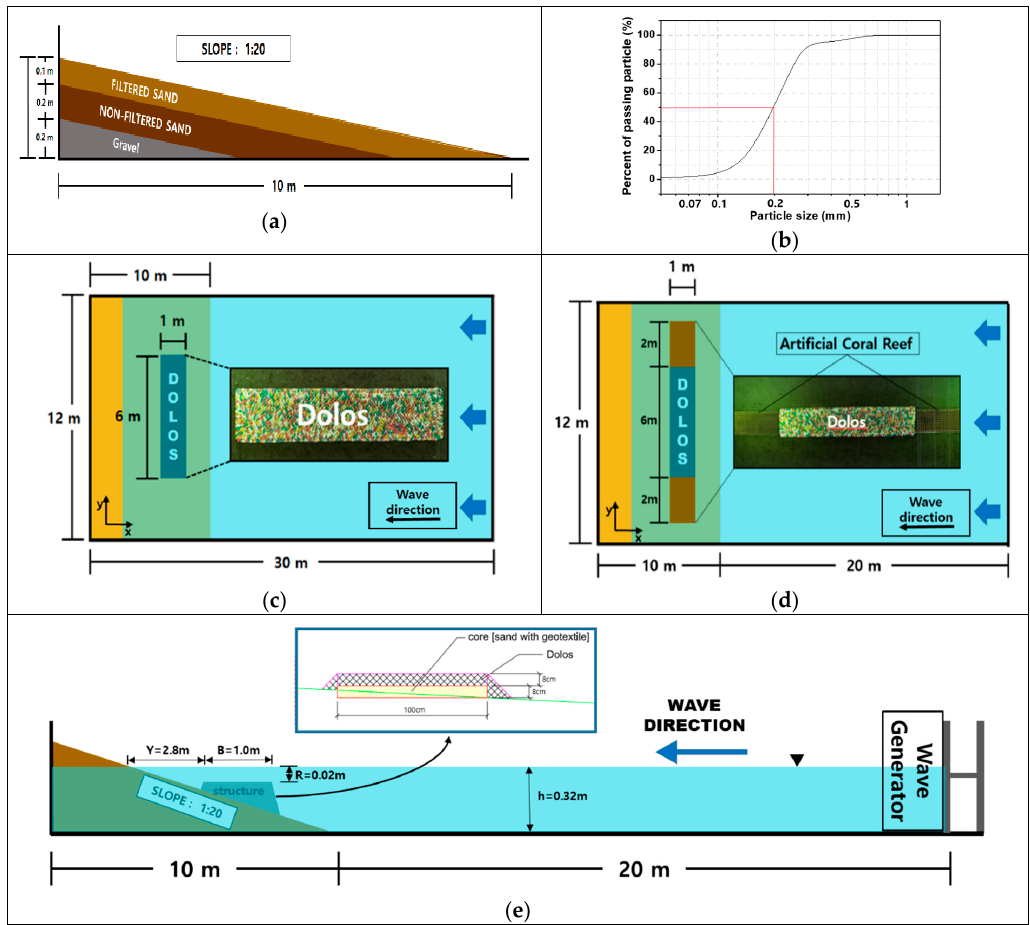
Table 1. Specification of the 3D hydraulic experiment.